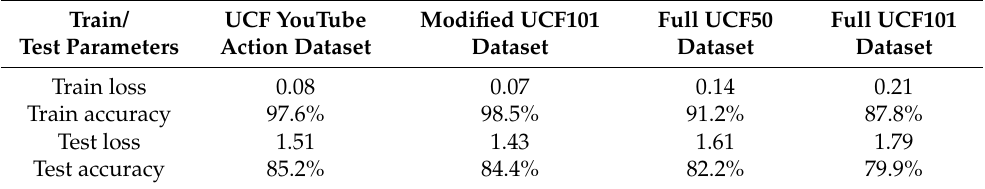
Table 4. Accuracy and loss function model during training and testing after 35 epochs.